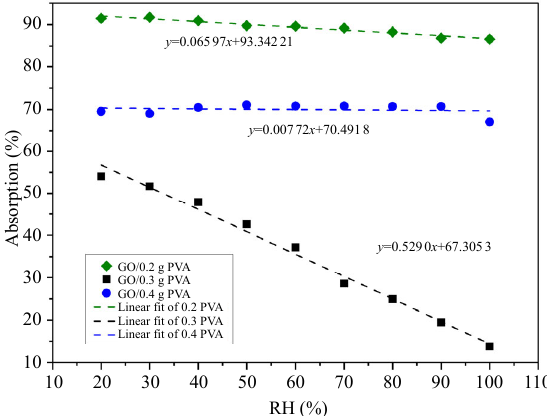
Fig. 8 Fitting line of the sensitivity of the sensor coating with different compositions at the wavelength of 700 nm.